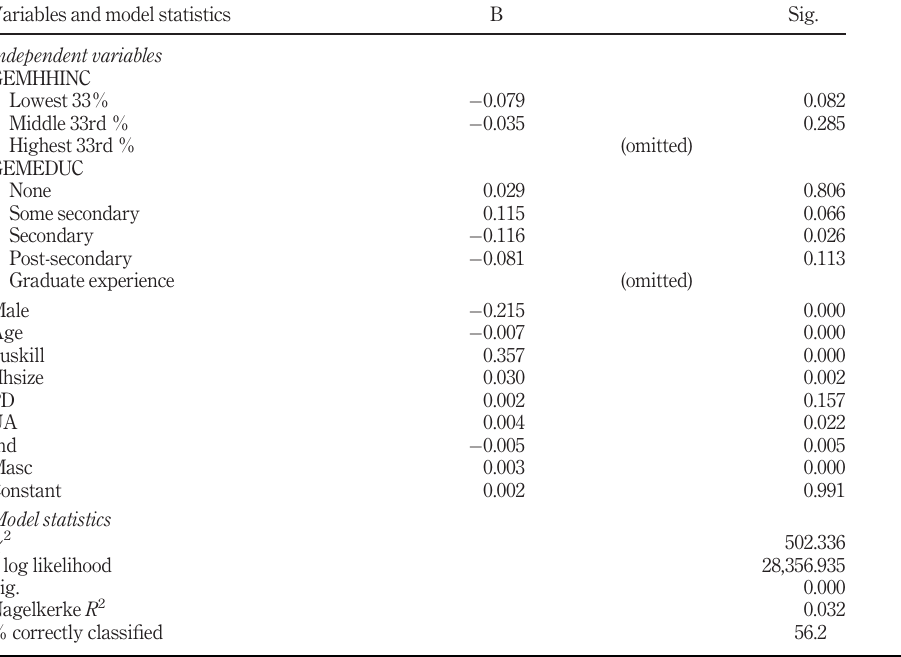
Table IV. Results of